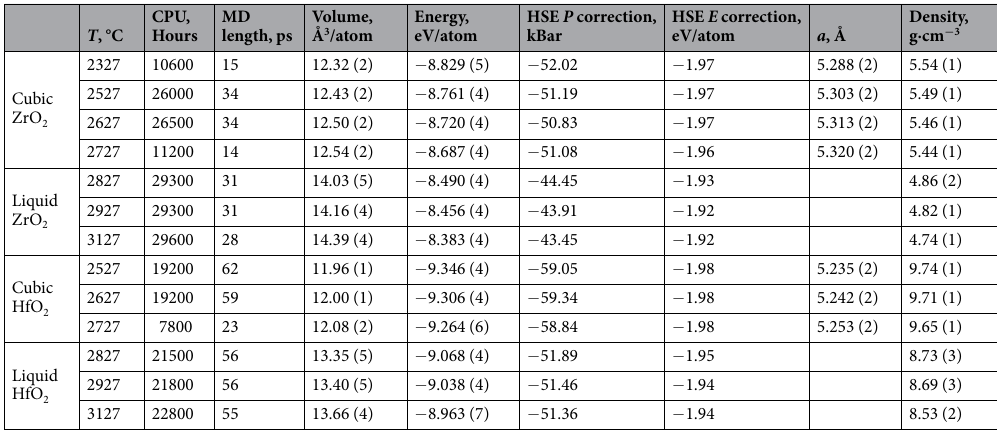
Table 1. Results of ab initio MD computations for ZrO 2 and HfO 2 on 270